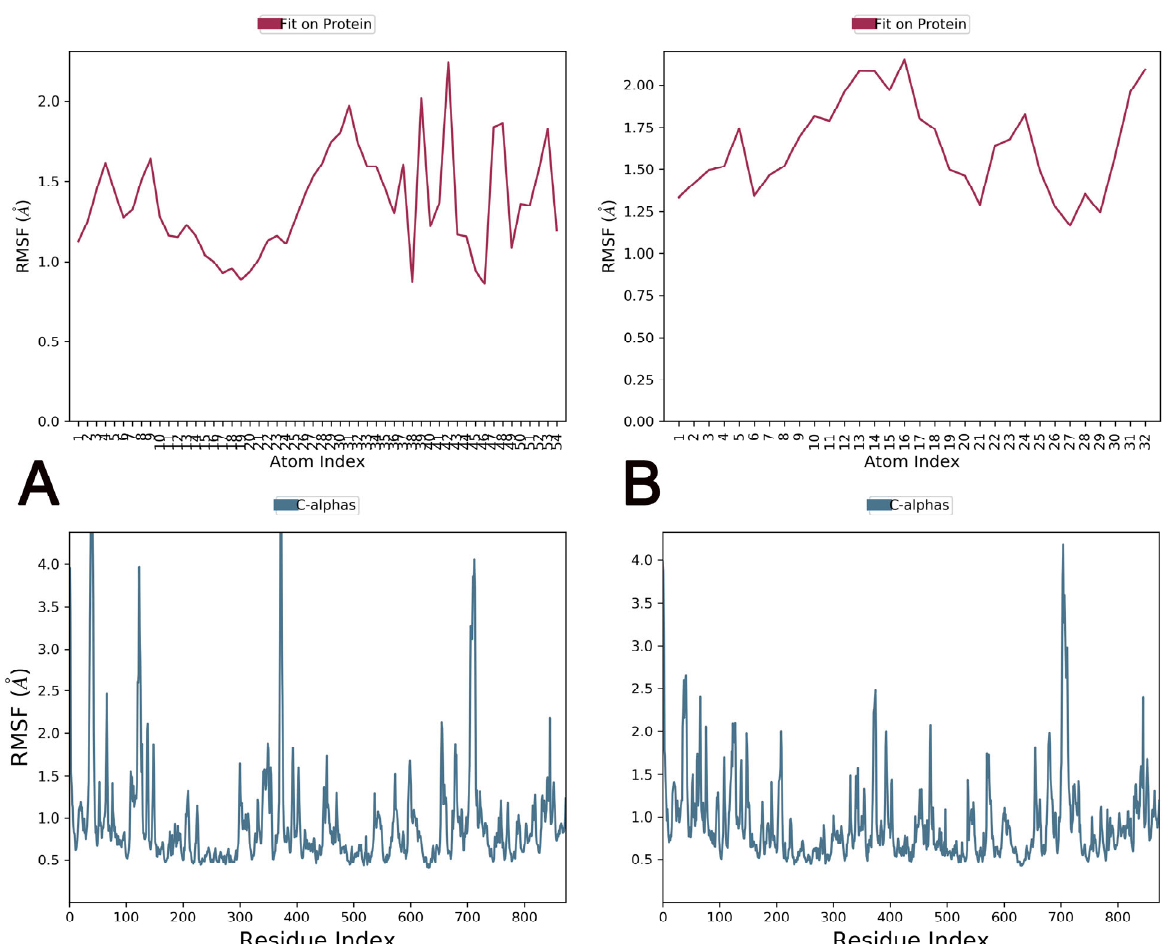
Figure 12. Upper panel: atom-wise RMSF of the Trabectedin ligand ( A ) and Demeclocycline ligand ( B ) with respect to the target protein ( α -glucosidase); Lower panel: residue-wise RMSF of α -glucosidase during simulation.